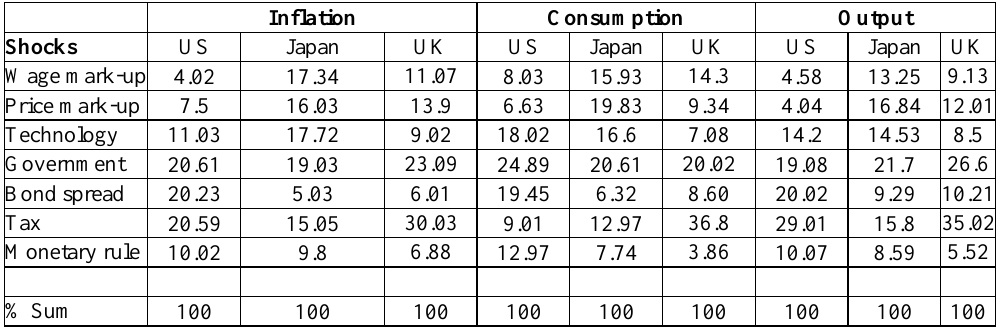
Table 4. Variance Decom. of the Optimal Calibrated Scenario (S High Fiscal Policy Involvement